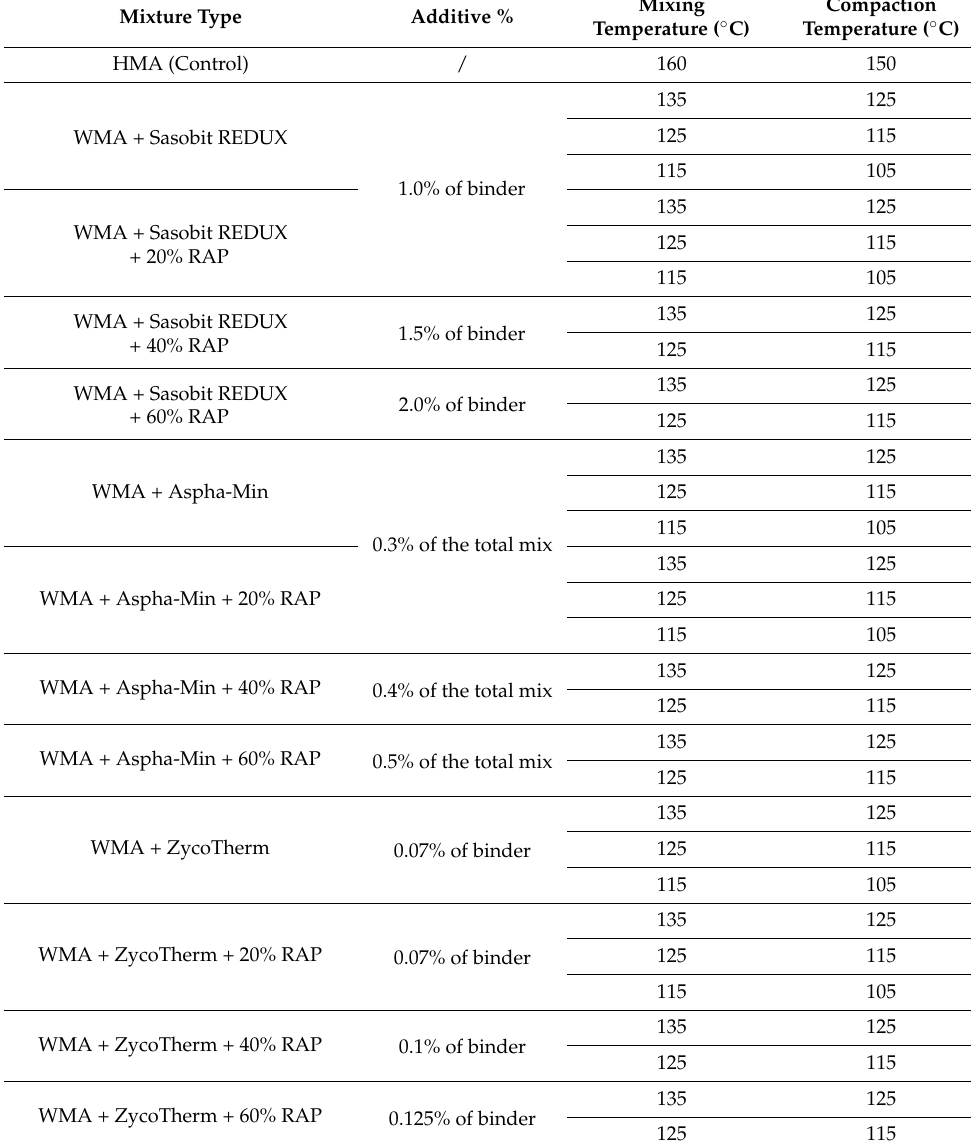
Table 15. Mixing and compacting